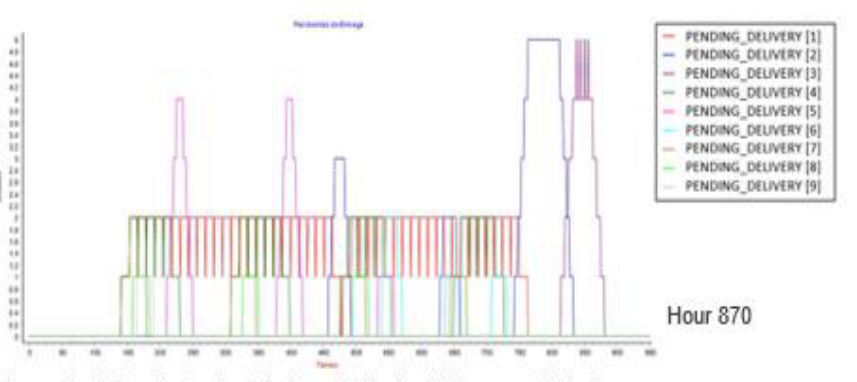
Figure 18. Behavioral contrast on pending delivery orders from the established scenarios. Source: own elaboration. Simulation results obtained from Evolution software.